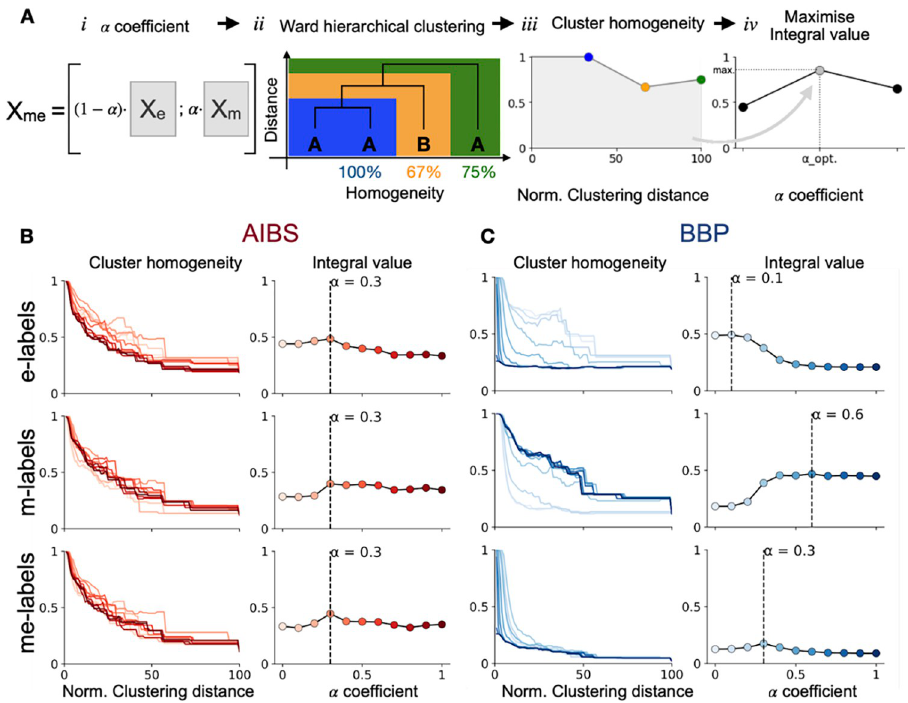
Fig 3. Optimization of α value. A. A parameter α controlled the weight between m and e features ( i ). We performed ward hierarchical clustering on the me-features matrix ( ii ). Cluster homogeneity with respect to a labelling system was computed depending on the hierarchical clustering distance ( iii ). We maximized the integral value to find the optimal α ( iv ). B. Optimization of α value using for electrical (e-labels), morphological (m-labels) and morpho-electrical (me- labels) labels of AIBS dataset. Left. Clusters average homogeneity depending on normalized clustering distance (percentage of maximal distance) for α ranging from 0 to 1 . Right. Integral values of the curves on the left panel for the different values of α . The dashed line shows the maximum integral value C. Same as in A but for the BBP dataset.